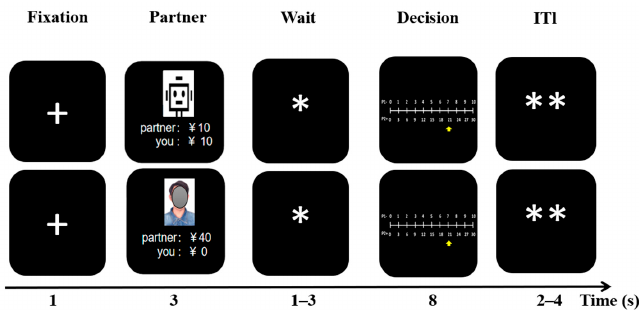
Figure 4. Example trust trial for TG (upper) and DTG (lower). The Fixation is displayed (1 s) and followed by the Partner screen (3 s). The face of a human partner (other recruited participants of the same gender) or computer-mediated partner (android image) is shown, together with the initial endowments for both players. After a Wait screen (1–3 s), the Decision screen prompts the trustor to choose an amount to give or take by moving the arrow with the left or right arrow key. The participants have a response restriction of 8 s. Then, the inter-trial interval ( ITI) screen appears with a jittered time of 2–4 s.